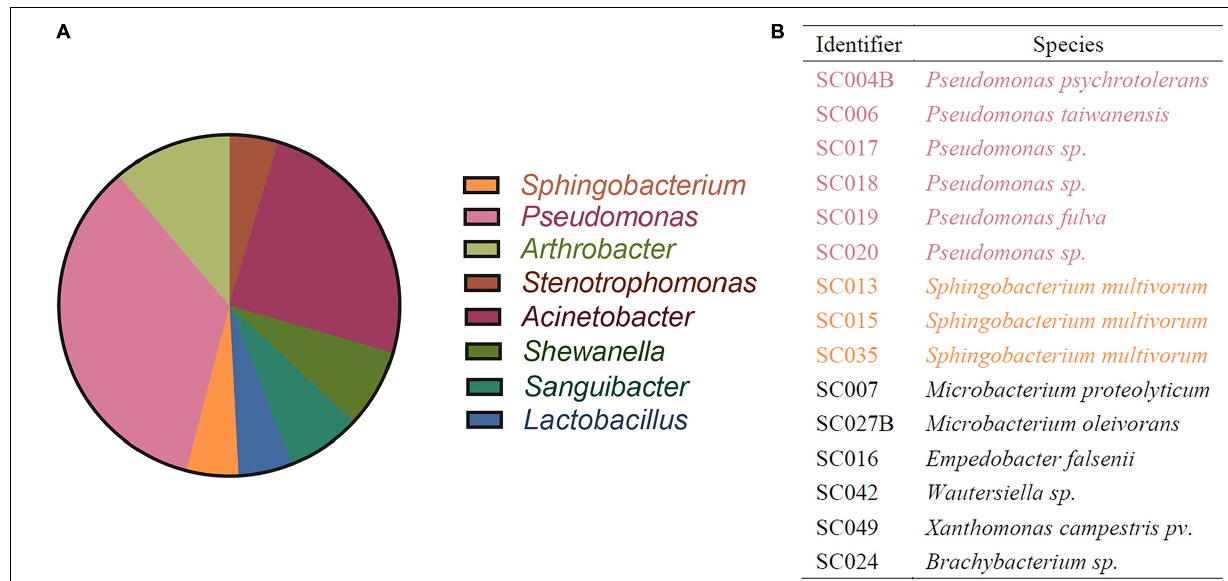
FIGURE 2 | Identification of bacteria by 16s rRNA sequencing. (A) Community composition of lettuce microbiome resolved in genus level; only genera with relative abundance > 1% are shown. (B) Identification of HBGA-SEB strains.